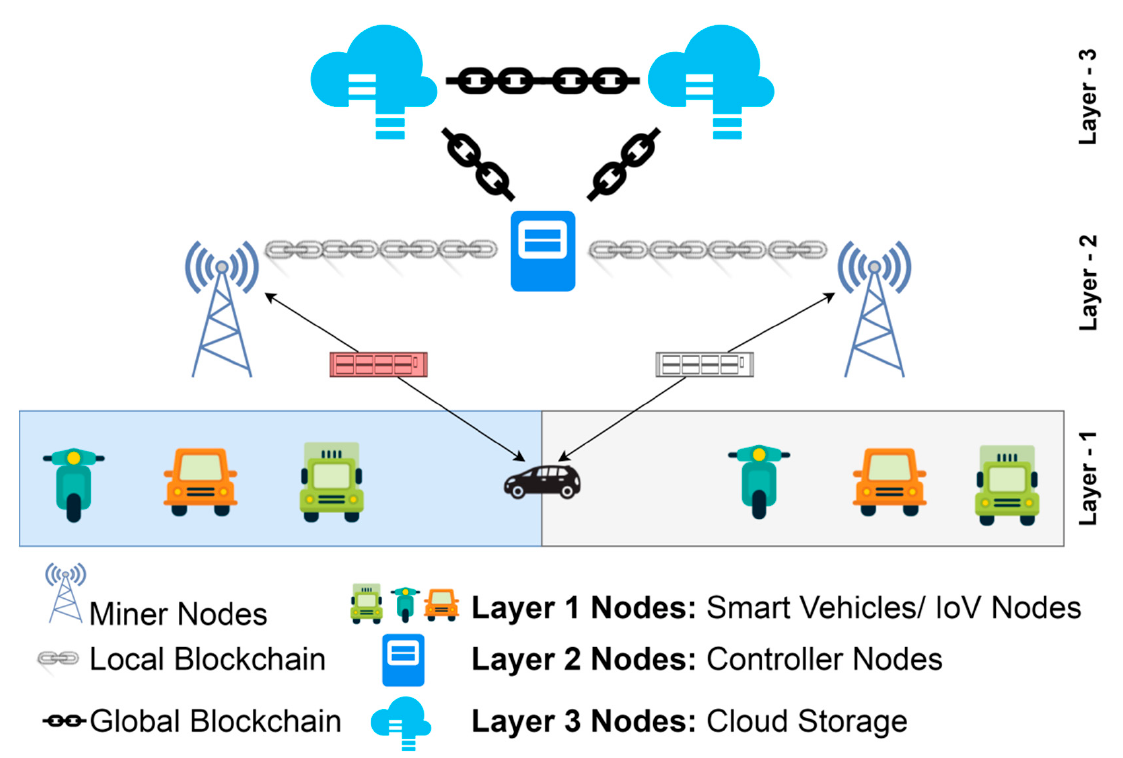
Figure 1. Three-layer blockchain-enabled and game theory-based authentication setup for IoVs.